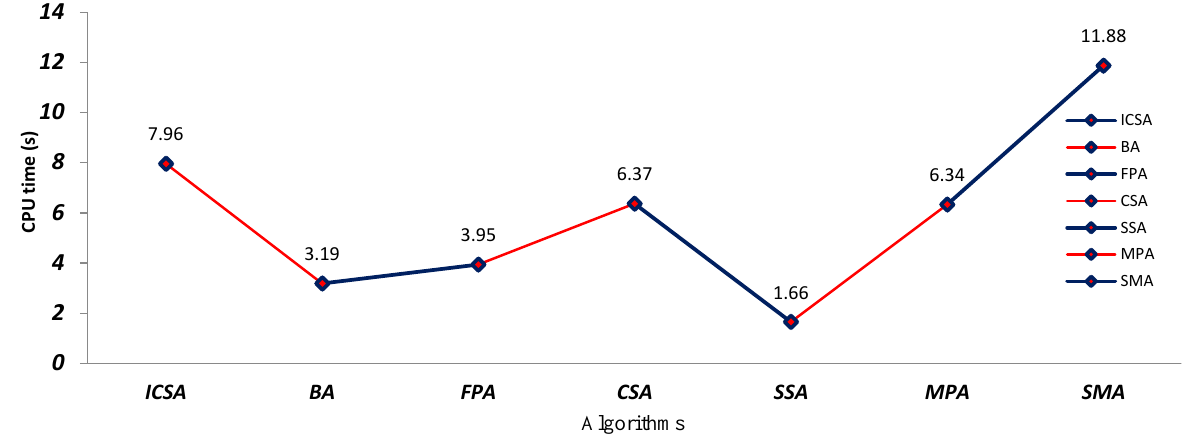
Figure 25. Comparison among algorithms in terms of CPU time.